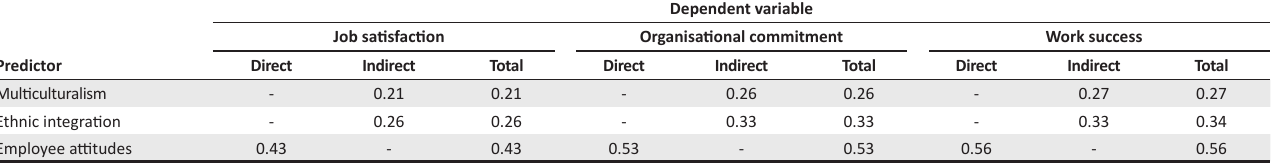
TABLE 4: Mediation effects of integration (standardised effects).